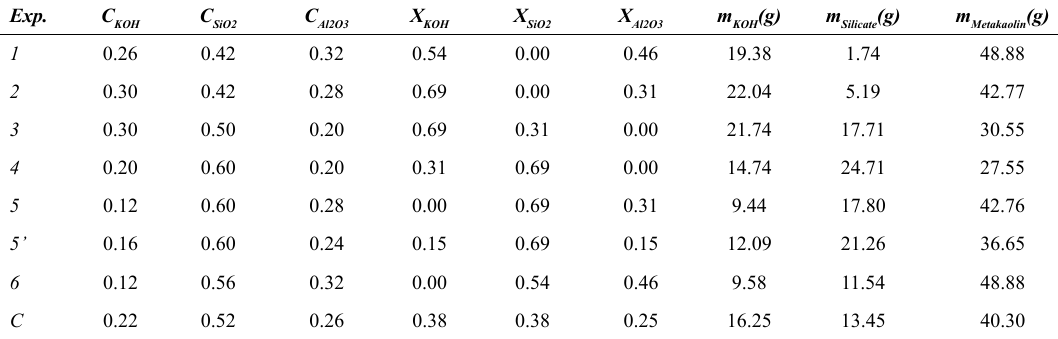
Table 2. Composition of the geopolymers in terms of real values and of pseudo-components.